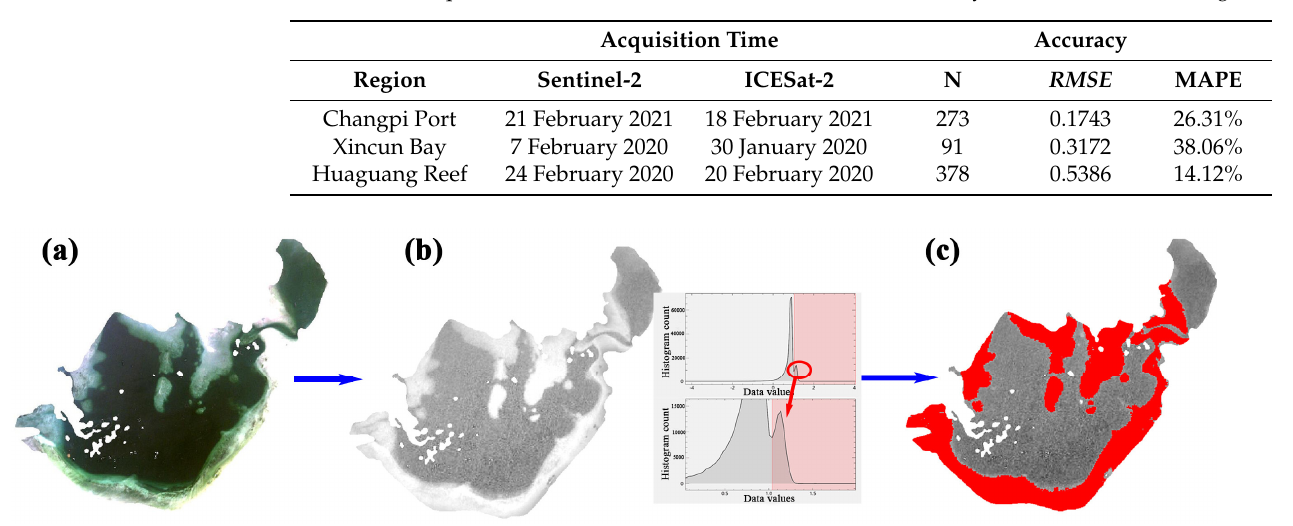
Figure 10. The process of extraction of optically shallow waters in Xincun Bay. ( a ) The atmospherically corrected Sentinel-2 imagery. ( b ) The Log − ratio OSWs for the whole imagery and the corresponding data value histogram for choosing the optimal threshold. ( c ) The extraction result of OSWs for Xincun Bay with red regions highlighted.